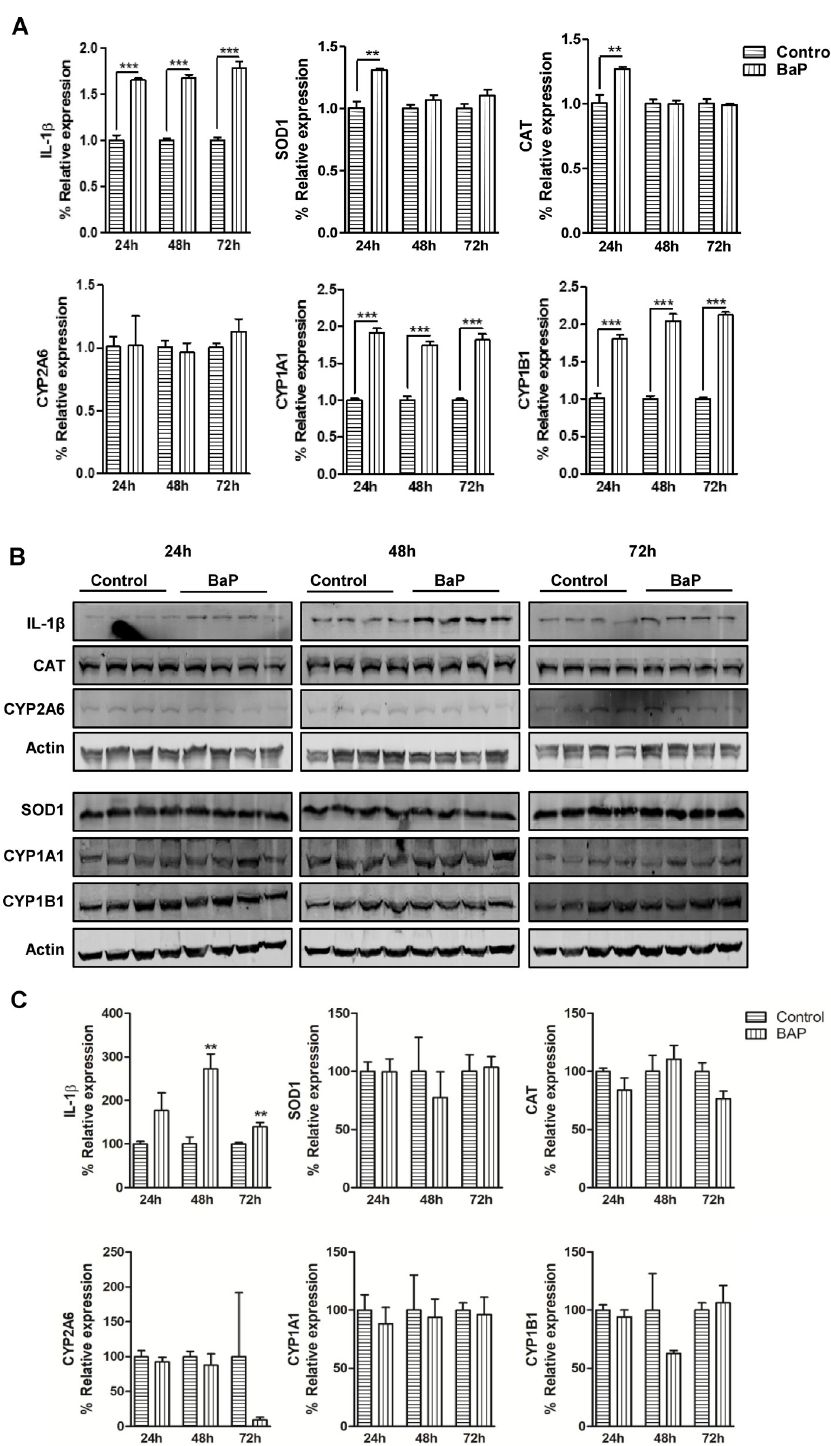
Fig 5. mRNA and protein expression of CYP enzymes, AOEs and cytokine IL-1 β (A-C). (A) mRNA expression was analyzed in SVG cells (at 24, 48, and 72 h) treated with 1 μ M concentration of BaP (daily treatment). (B) Representative western blots of IL-1 β , AOEs (SOD1 and CAT), and CYP enzymes (CYP2A6, CYP1B1, CYP1A1) in SVG cells (Western blot at 24, 48, and 72 h) treated with 1 μ M concentration of BaP (daily treatment). Untreated controls were considered as 100% in the densitometry analysis. (C) Densitometry analysis. Statistical analyses were